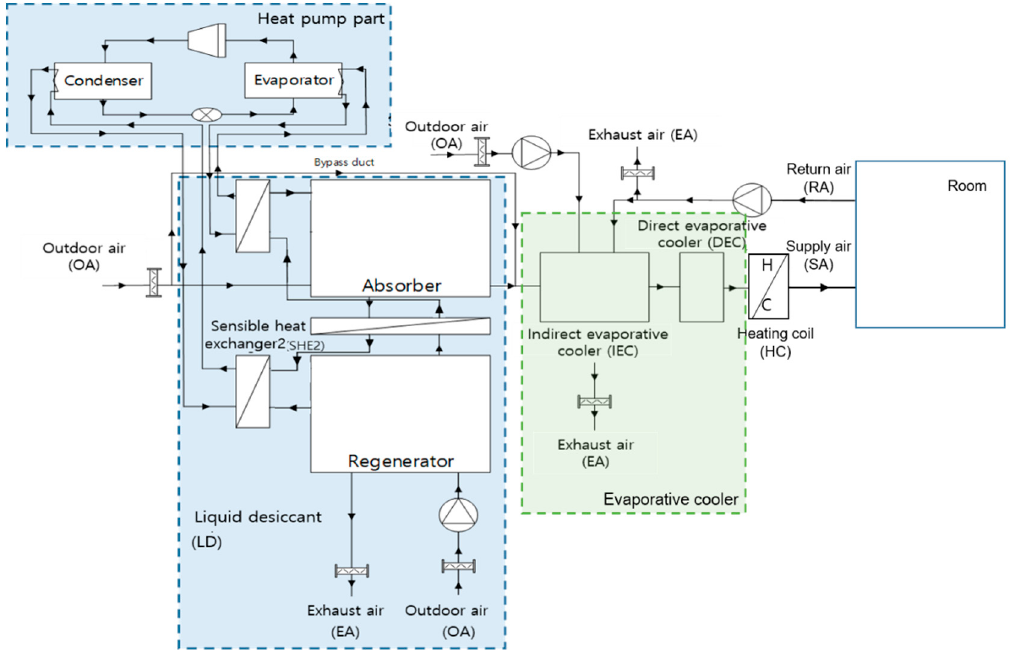
Figure 1. Liquid desiccant and the indirect and direct evaporative-cooler-assisted 100% outdoor air system (LDIDECOAS).